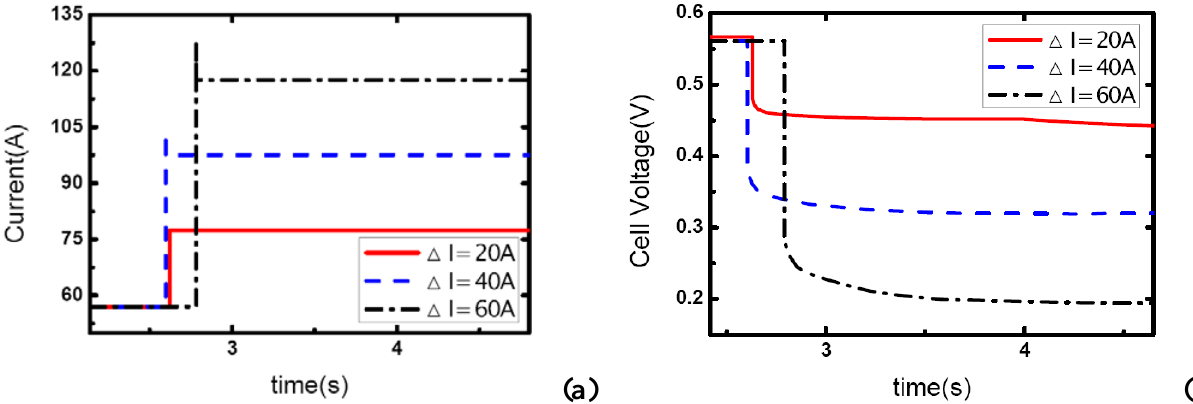
Figure 2. (a) Current change as three different step amplitudes while λ 1.95, (b) corresponding dynamic voltage